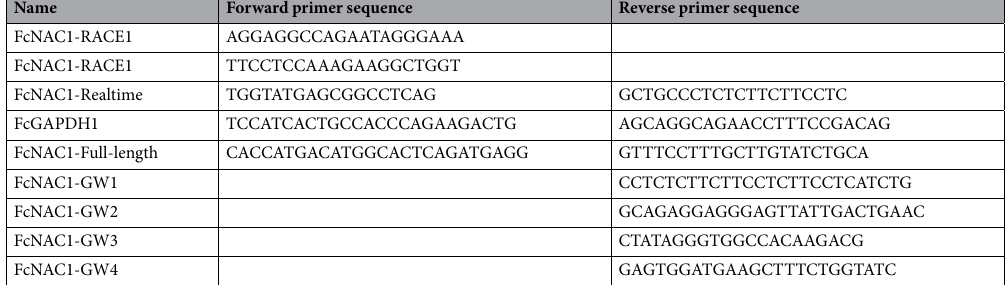
Table 1. Nucleotide sequence of the primers (5 ′ → 3 ′ ) used in this